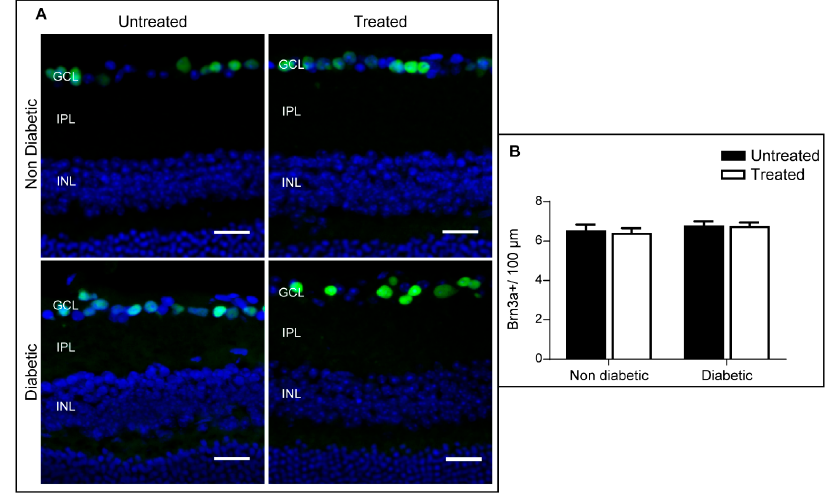
Figure 6. Retinal ganglion cell number is unaffected by STZ-mediated diabetes. Cryosections from each experimental condition were stained for Brn3a (green) and counterstained with DAPI (blue). The average number of Brn3a + ganglion cells were quantified and normalised to 100 μ m of retina length. ( A ) Representative images for each condition. GCL: ganglion cell layer; IPL: inner plexiform layer; INL: inner nuclear layer. Scale bar: 25 μ m. ( B ) Average number of Brn3a + cells per 100 μ m. Data are shown as mean ± SEM. n > 30 images from 3–5 different animals per experimental condition. Two-way ANOVA with Sidak’s test.